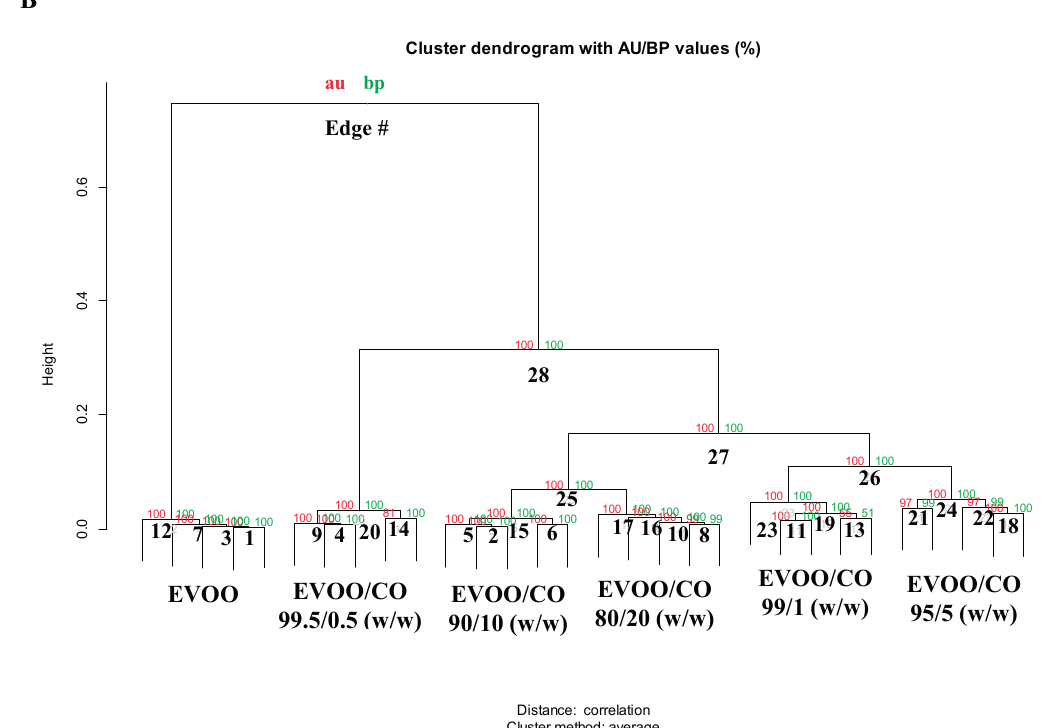
Figure 3. Pearson’s correlation matrix ( A ) and UHC tree (bootstrap n = 1000) ( B ) generated via pvclust of all spectral replica for the five mixtures (from 20% to 0.5%) of simulated adulterations of EVOO with CO. Correlation coefficients are represented with decreasing blue and yellow colors according to a scale ranging from 0 to 1, respectively. Values on the edges of the clustering are p -values (%). Red values are AU (Approximately Unbiased) p -values, and green values are BP (Bootstrap Probability) values as explained in the Experimental section.